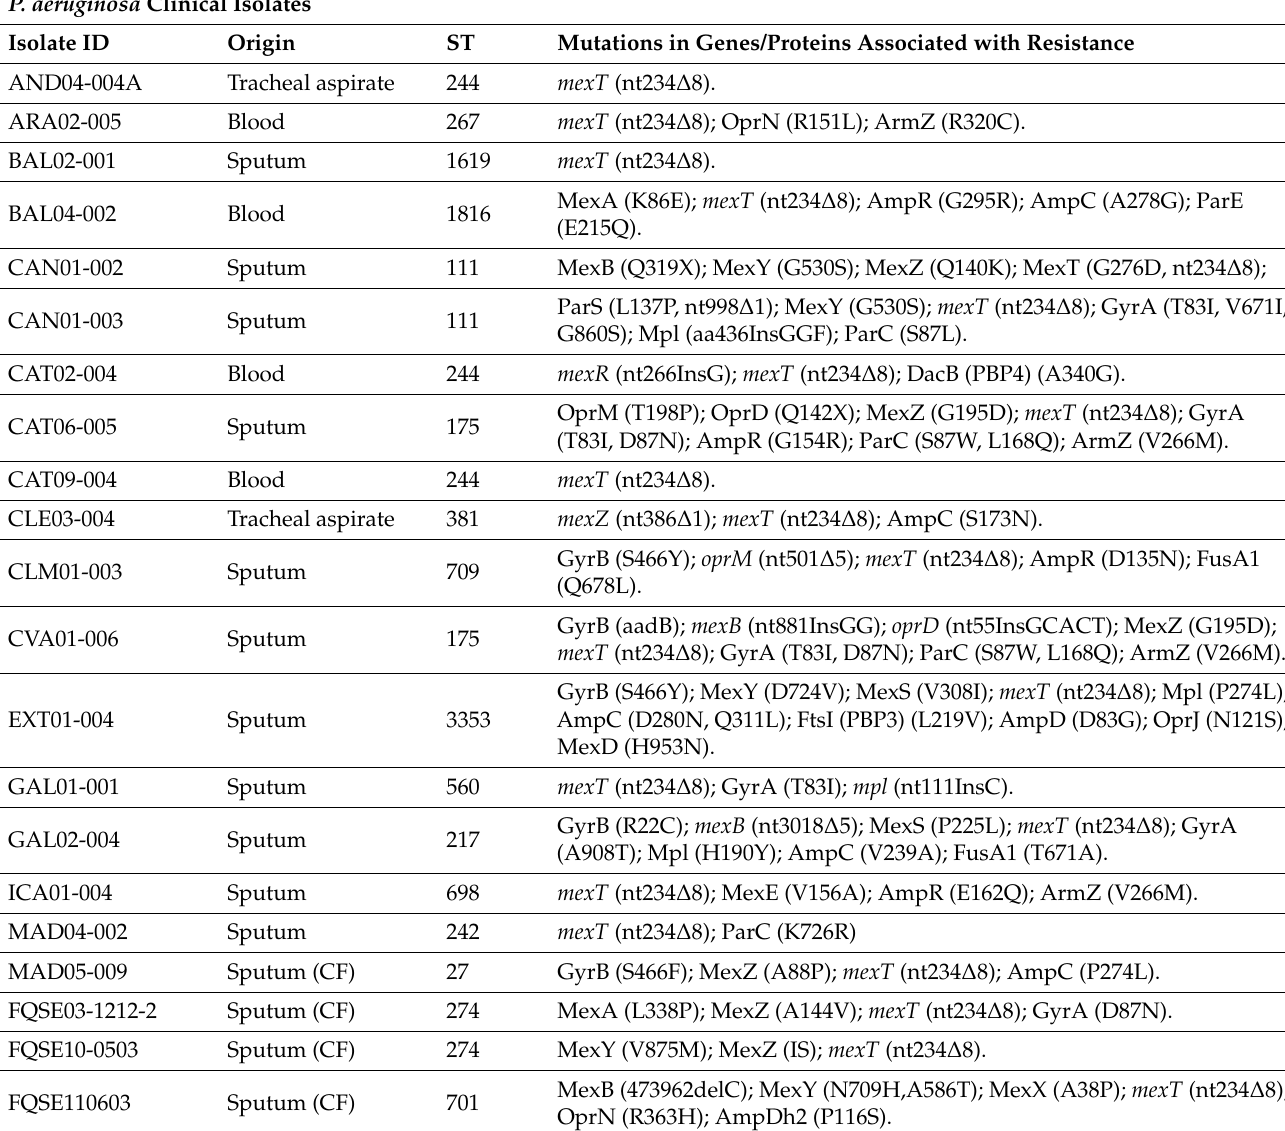
Table 1. Bacterial strains used in this